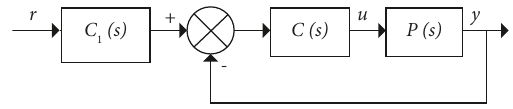
Figure 13: Te block diagram of second-order